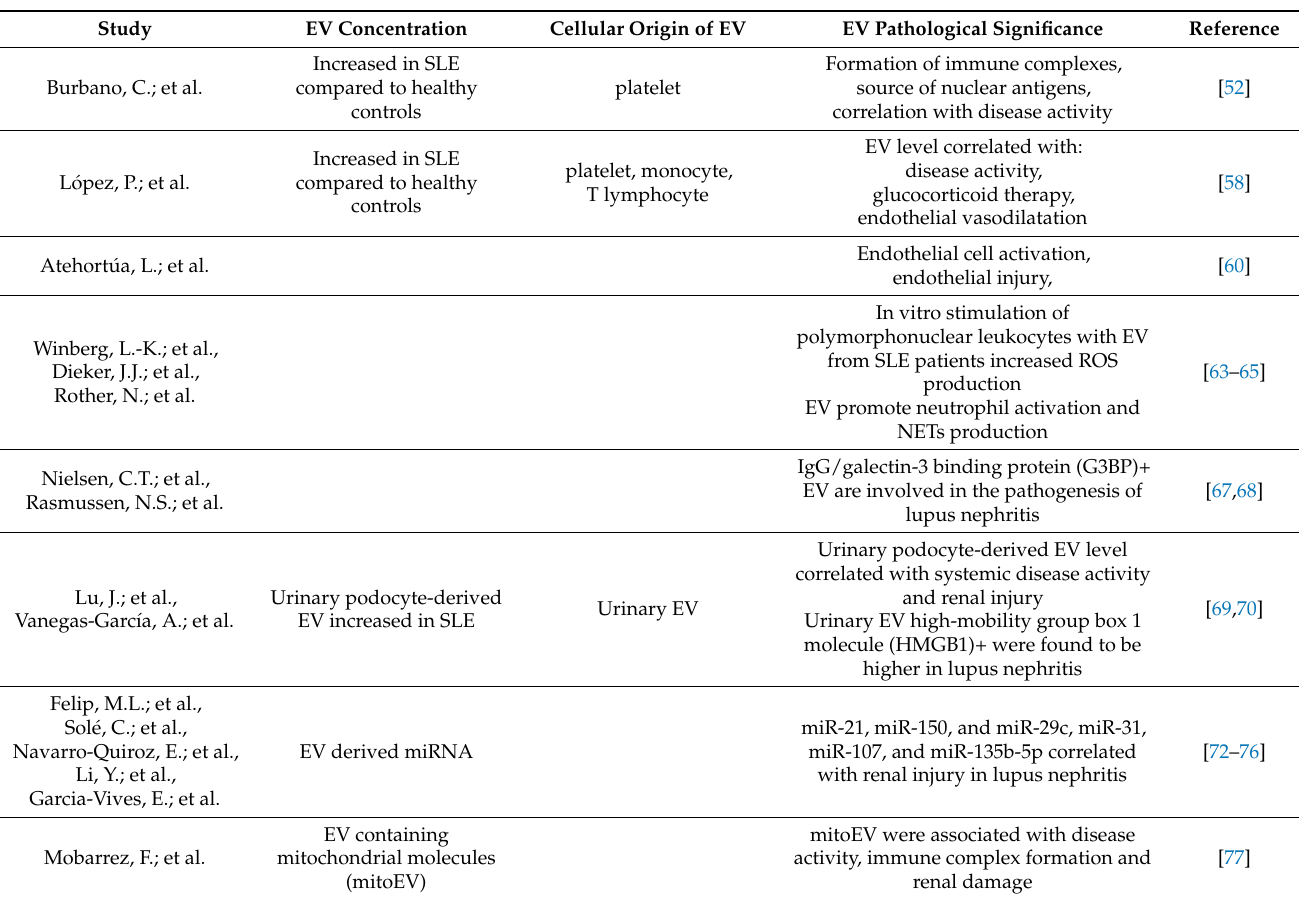
Table 2. Extracellular vesicles in systemic lupus